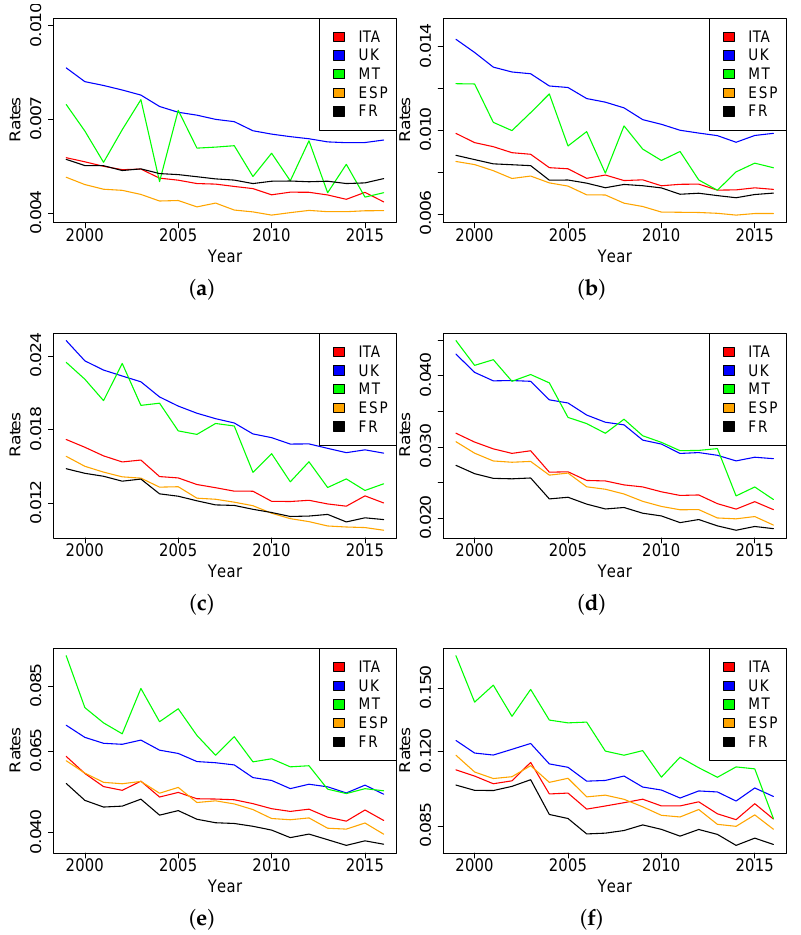
Figure 1. Age(-range)-specific female death rates: ( a ) at age 60–64, ( b ) at age 65–69, ( c ) at age 70–74, ( d ) at age 75–79, ( e ) at age 80–84, ( f ) at age